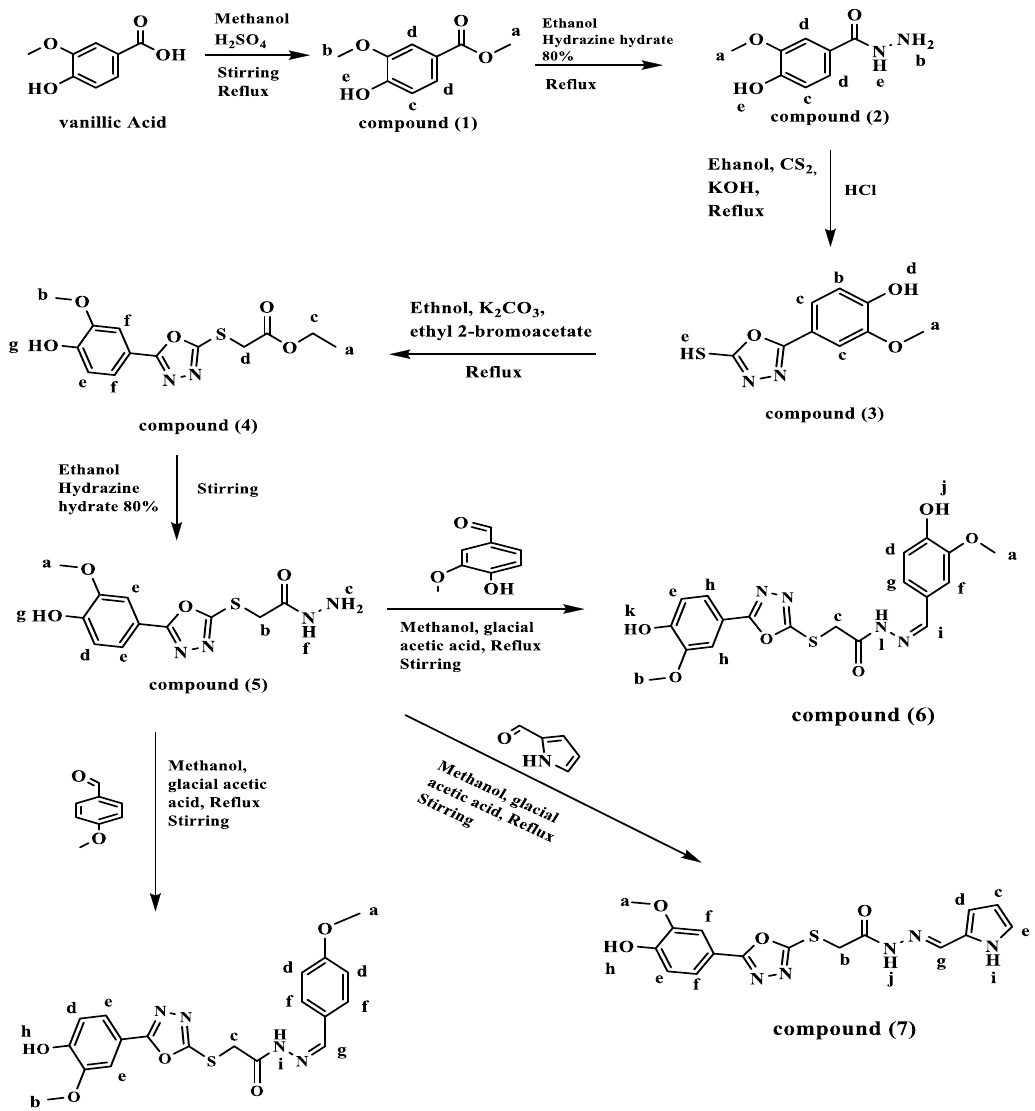
Figure 1. Multistep(s) scheme for synthesis of targeted